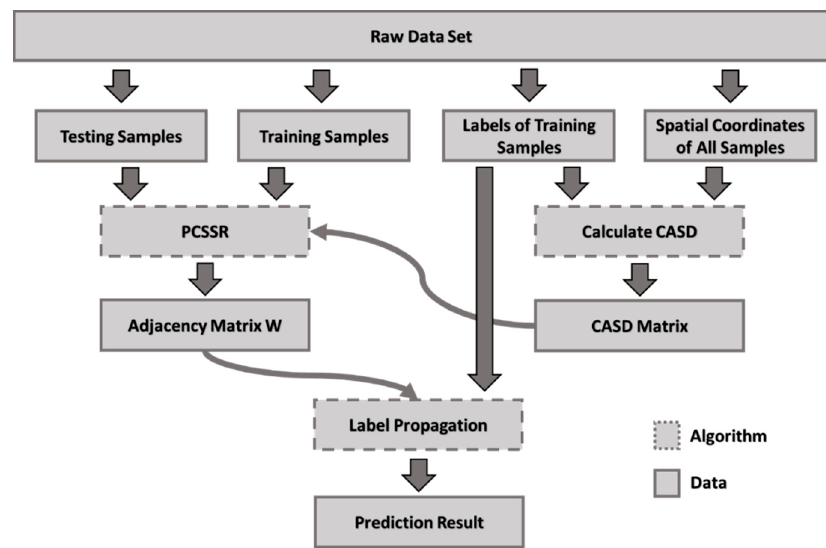
Figure 1. The general flow of the proposed class adjusted spatial distance (CASD)-assisted hyperspectral image (HSI)_classification method.